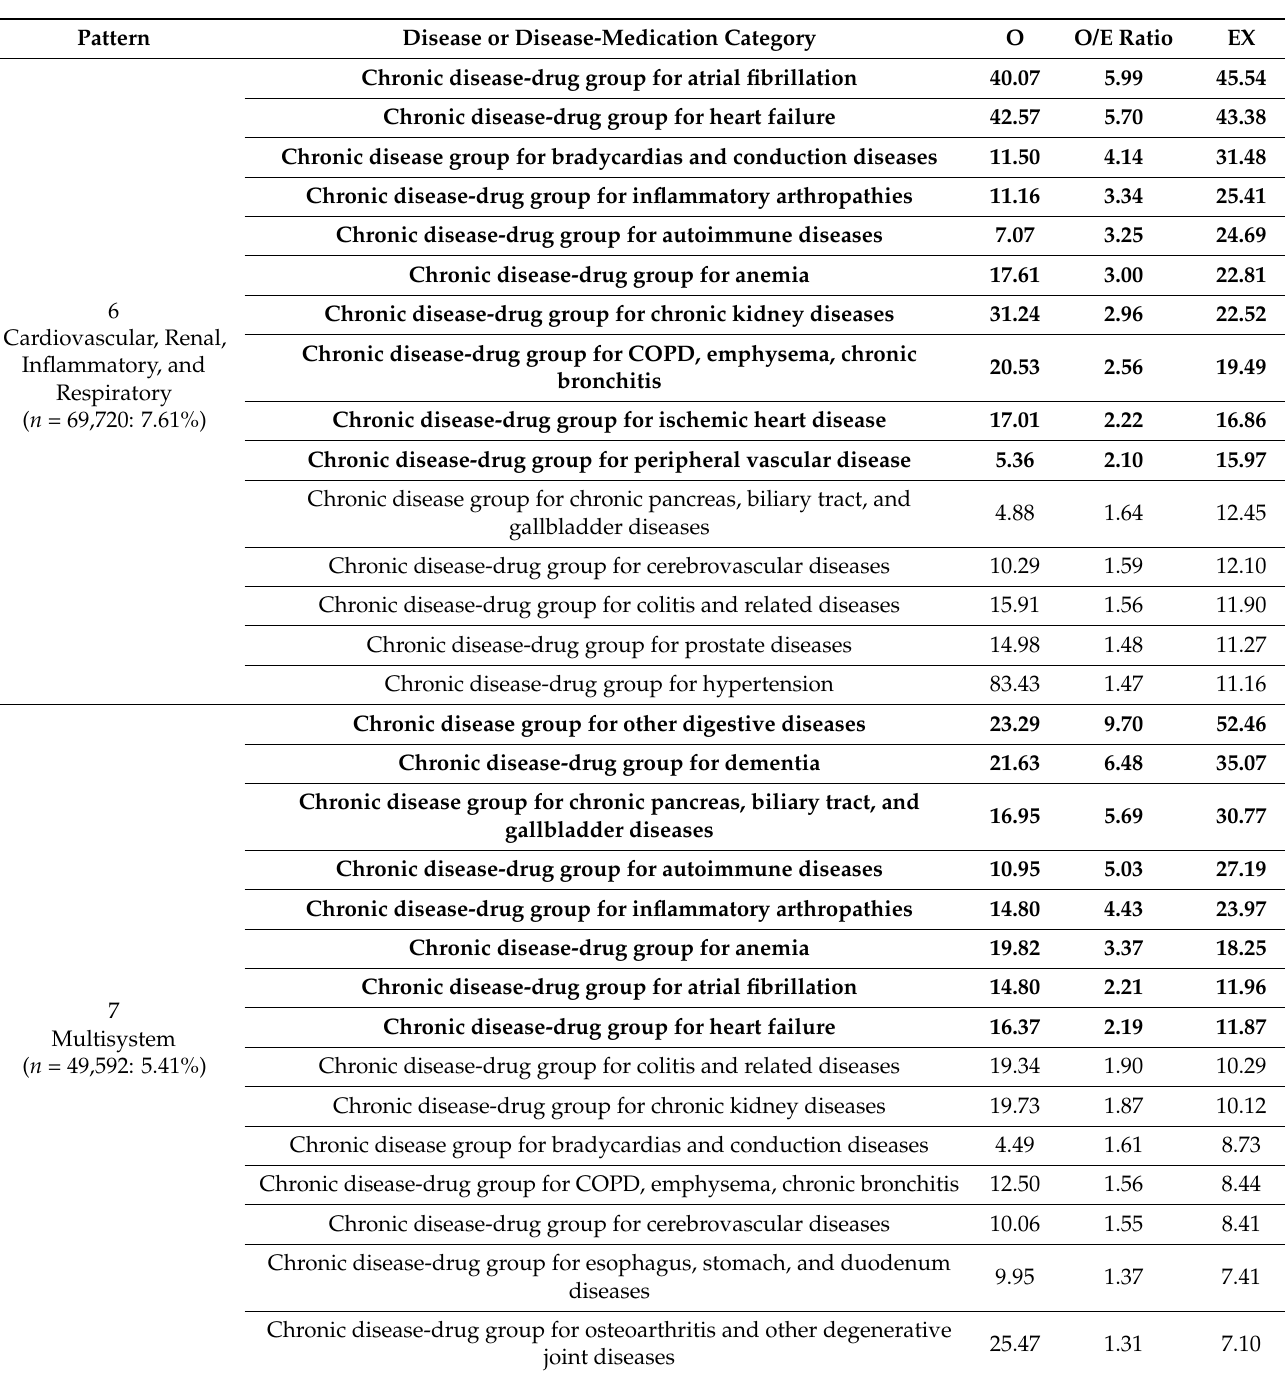
Categories highlighted in gray are chronic disease categories; those in white are chronic disease-drug categories. Categories in bold reach the O/E ratio threshold of two. Abbreviations: O: disease prevalence in the cluster; O/E ratio: observed/expected ratio; Ex: exclusivity; COPD: chronic obstructive pulmonary